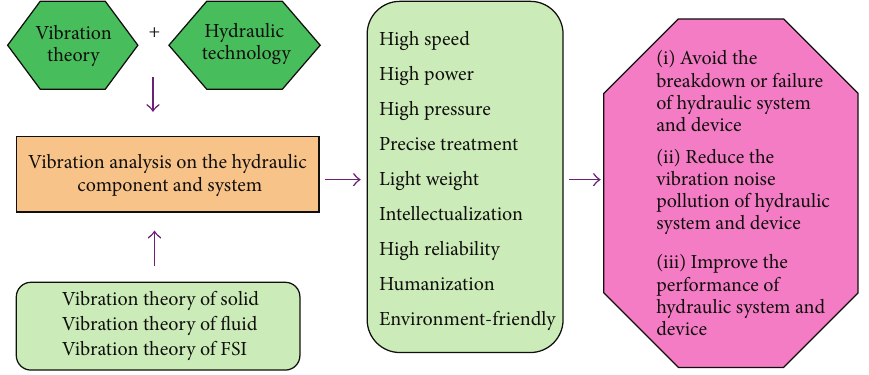
Figure 1: Vibration analysis: hydraulic component and system.